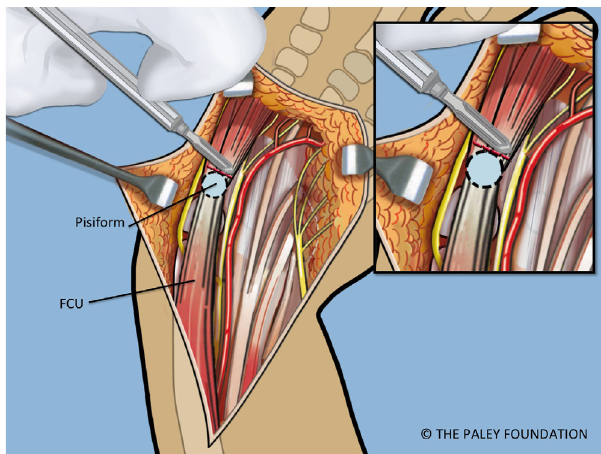
Figure 4. The abductor digiti minimi is released off of the pisiform bone. The pisiform bone is separated from the